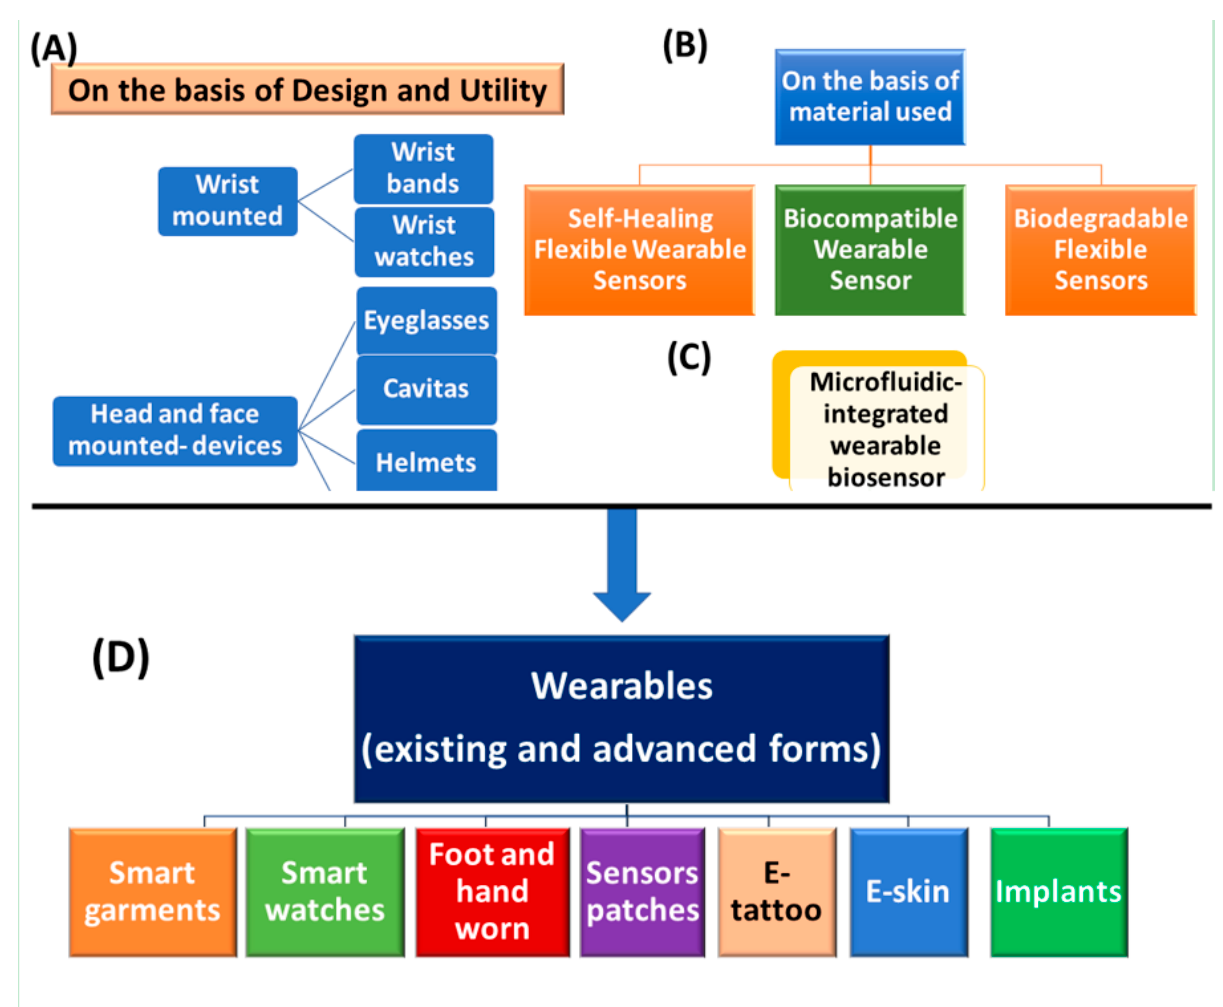
Figure 2. Classification and different forms of wearable devices and accessories ( A ) on the basis of design and utility; ( B ) on the basis of material employed in the construction of wearables biosensor; ( C ) on the basis of transduction principle; ( D ) existing and advanced forms of wearable devices.